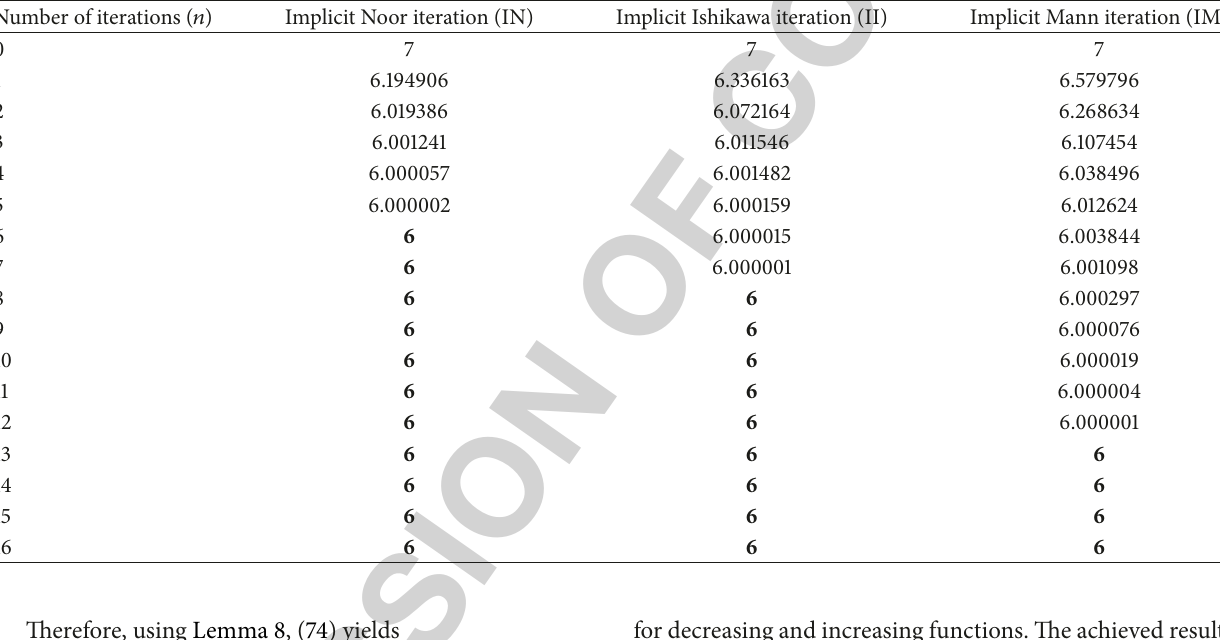
Table 3: Convergence of implicit iterations to the fixed point of increasing